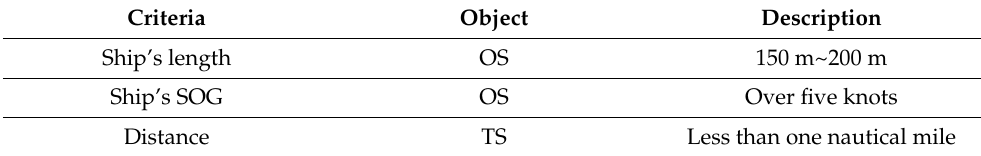
Table 2. Ship-to-ship CRS extraction criteria.